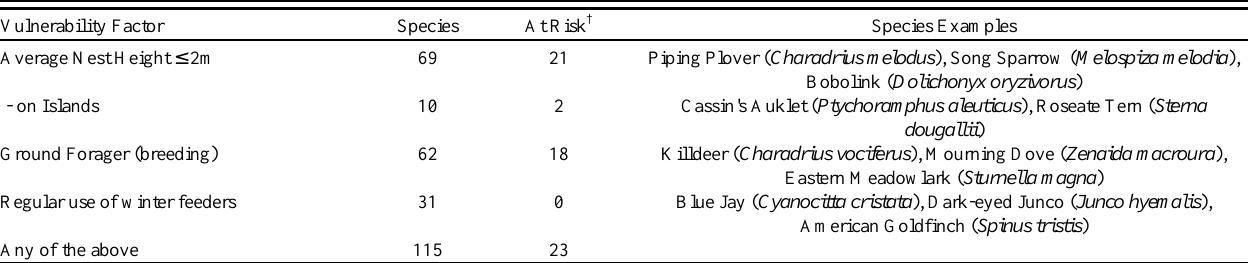
Table 5 . Number of species in southern Canada with characteristics that make them vulnerable to predation by cats. See Appendix for list of species.